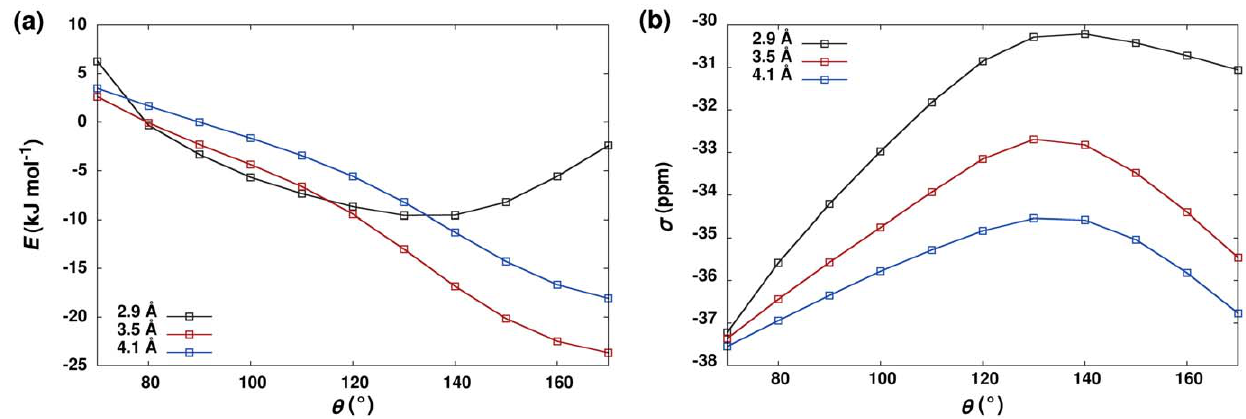
Figure 6. Summary of Quantum Chemical Calculations for ‘End-On’ Dipole Interaction. Plots of ( A ) interaction energy and ( B ) carbonyl 13 C chemical shielding ( s ) as a function of the angle between the carbonyls ( h ) for three different distances ( d ) between the donor oxygen and acceptor carbon.